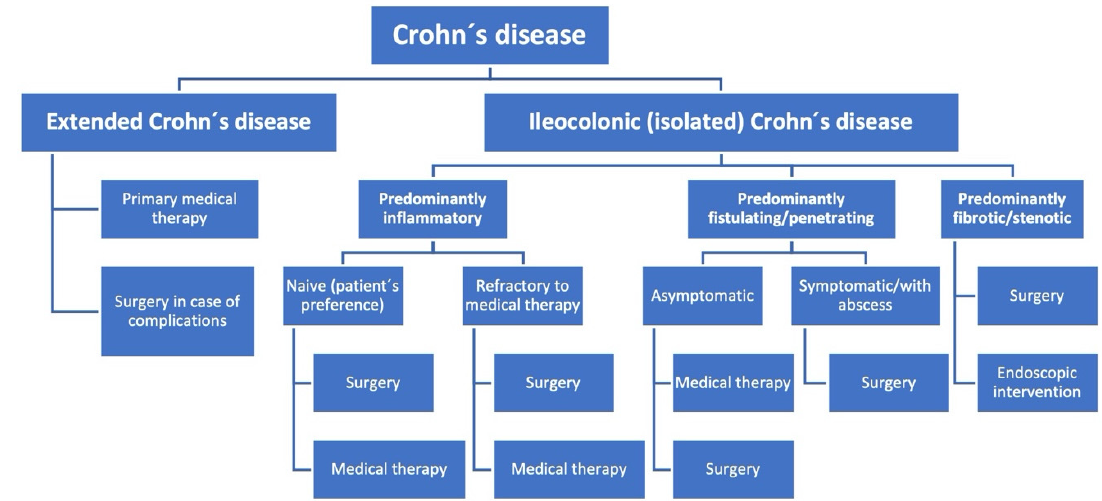
Figure 1. Flow chart for treatment strategies in Crohn’s